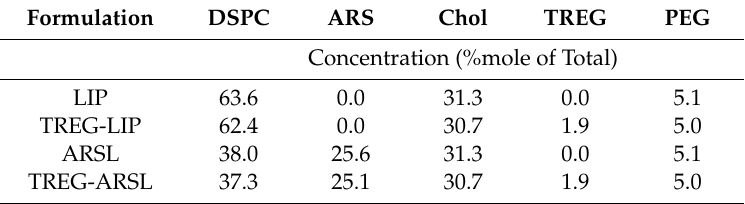
Table 1. Lipid compositions of arsonoliposomes (ARSL), TREG-ARSL, as well as liposome formulations without arsonolipids, plain Liposomes (LIP) and TREG-LIP, which were used as control formulations. Formulation DSPC ARS Chol TREG PEG Concentration (%mole of Total) LIP